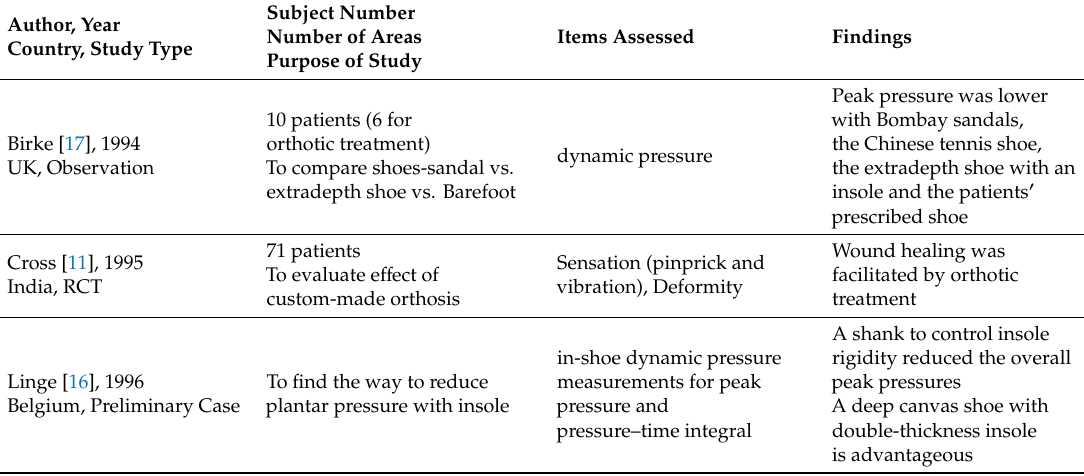
Table 3. Research on the orthotic treatment for plantar ulceration in Hansen’s